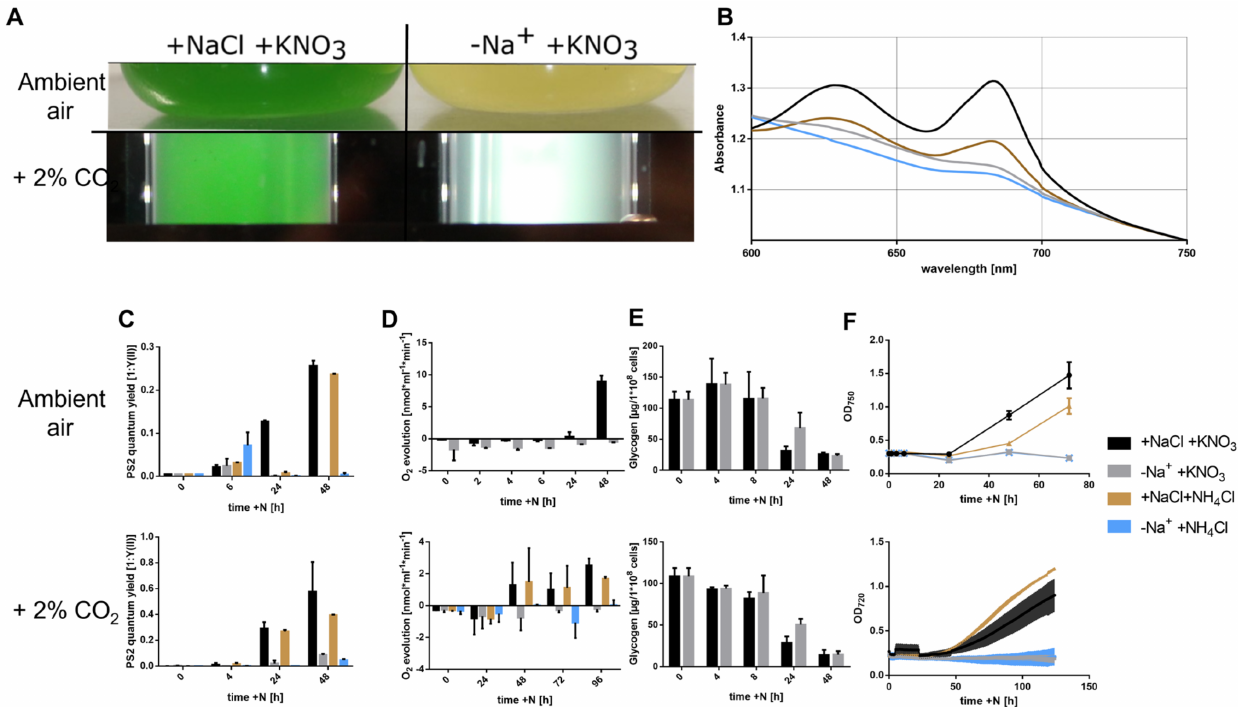
Figure 1. Resuscitation in the absence of Na + is impossible. ( A ) shows two cultures after 14 days of chlorosis and two days of resuscitation in ambient air (top) or supplemented with 2% CO 2 ( bottom ), the left in presence of Na + and the right in absence thereof. ( B ) shows the absorbance of recovering cultures in ambient air from 600 nm to 750 nm. ( C ) shows the quantum yield of PSII as a measure of photosynthetic activity. ( D ) shows the oxygen evolution during resuscitation. ( E ) shows glycogen consumption. ( F ) shows the OD at 750 nm (top) or 720 nm (bottom) as an indicator of cell mass. ( C – E ) top graphs refer to cultures in ambient air, bottom graphs refer to cultures in a 2% CO 2 environment. Samples were taken 0, 4, 6, 24, and 48 h after the addition of 10 mM KNO 3 or 10 mM NH 4 Cl, respectively. Each data-point represents measured triplicates. Error bars represent the